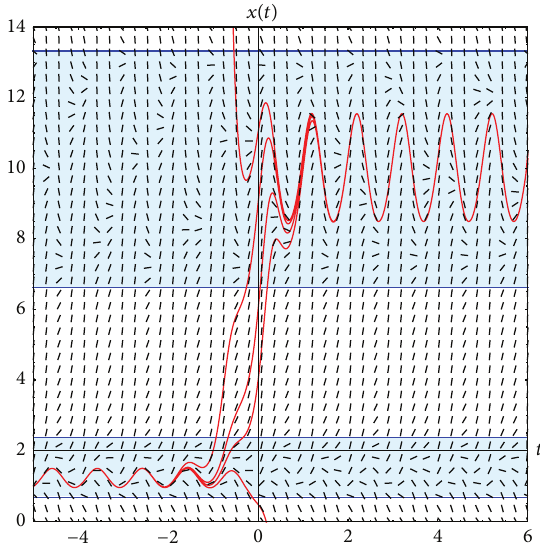
Figure 1: Tighter estimates for both periodic solutions of